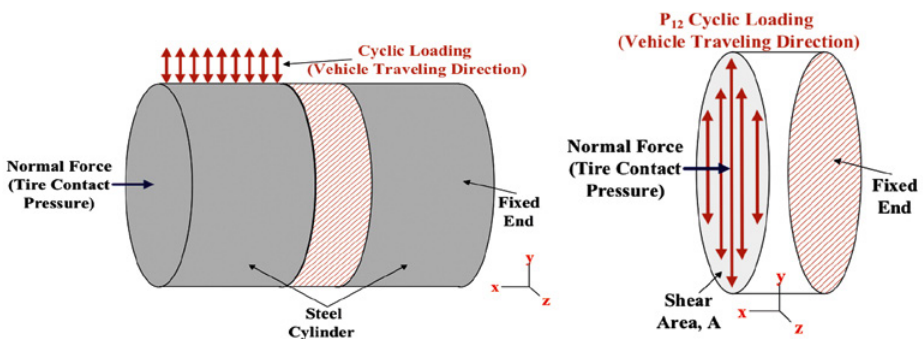
b) schematic of the test setup c) mode of loading on thin